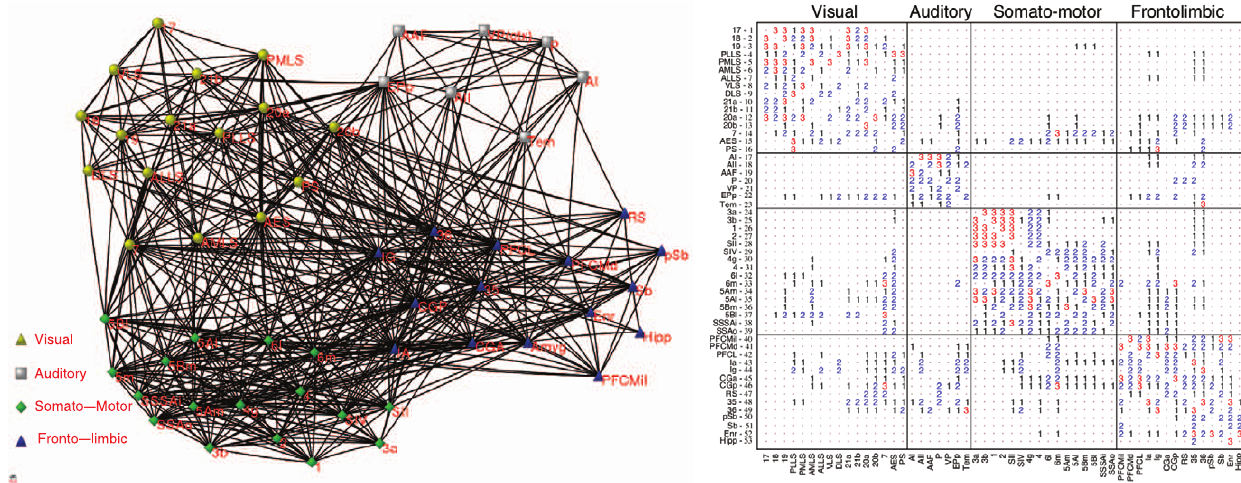
Figure 1. The brain cortical network of the cat. On the left we show the topology of the nodes (areas) and links (axon interconnections) between them. On the right the weighted adjacency matrix is shown. The weight of the links denote the axon density between two connected areas. Besides the matrix shows the partition of the network into four main modules of modally-related areas: Visual, Auditory, Somatosensory-Motor and Fronto-Limbic.